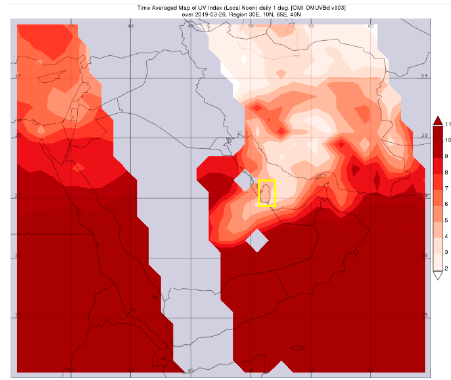
Figure 13. OMI Aura UVI plots for the Arabian Peninsula on the 26 March, 2019 generated using NASA’s GIOVANNI platform. Qatar is highlighted in a yellow box.